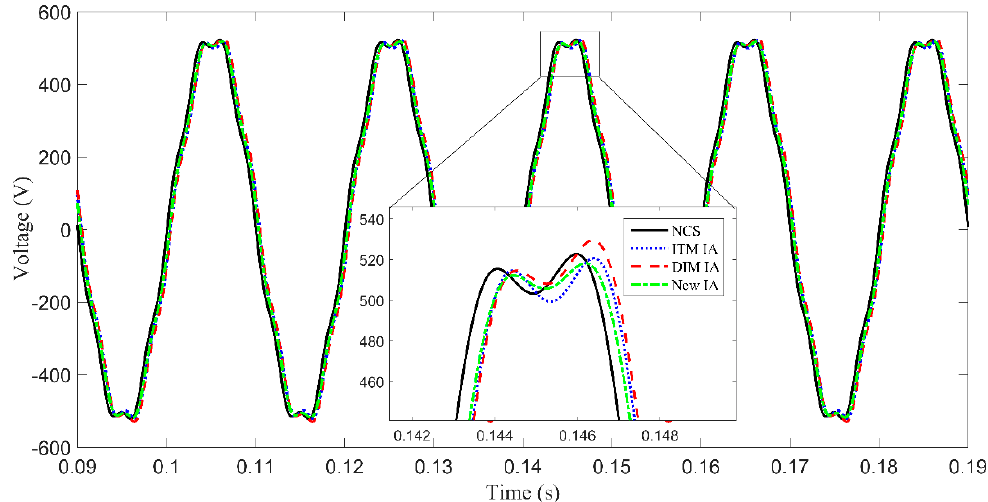
Figure 7. Voltage waveform of the DUT side by using the new IA.